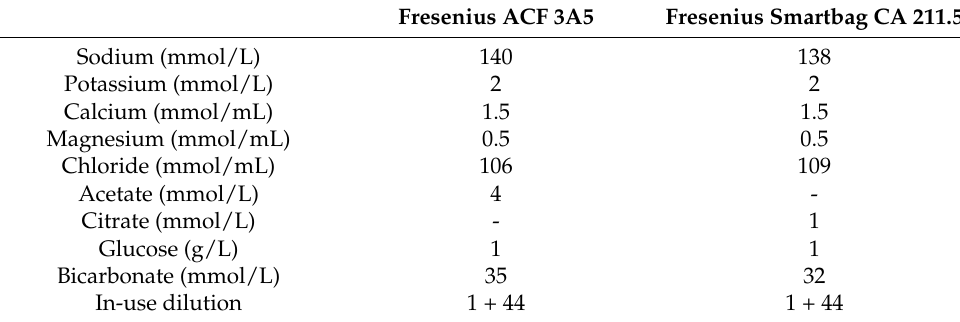
Table 2. Dialysate characteristics and